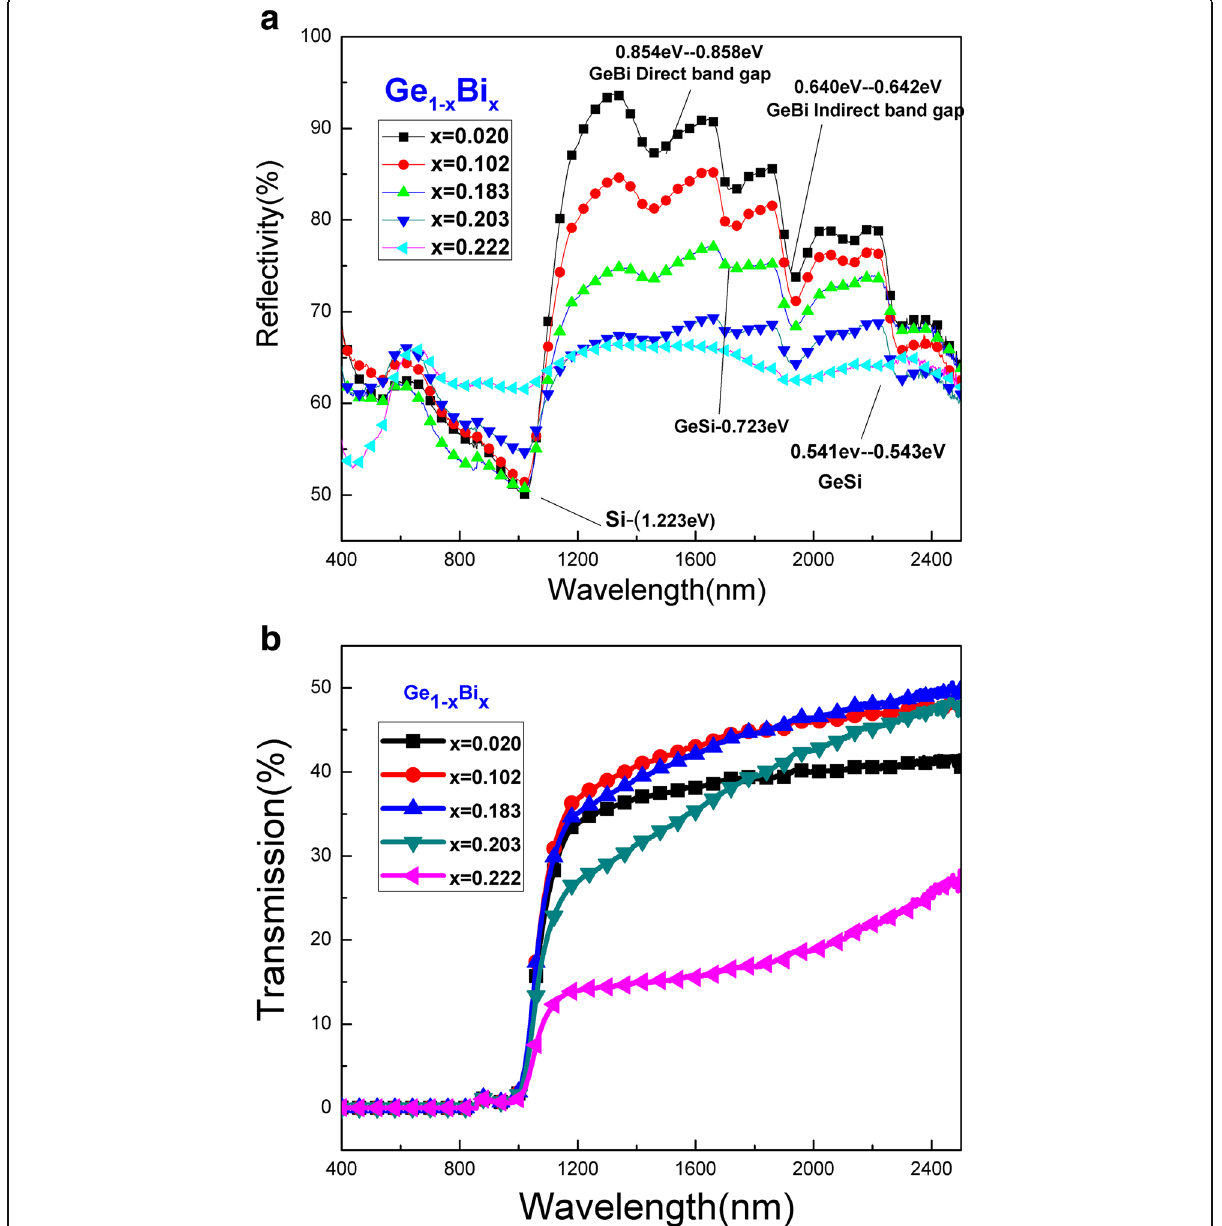
Fig. 5 Reflectance spectra ( a ) and transmission spectra ( b ) of GeBi films with different Bi contents in near-infrared wave